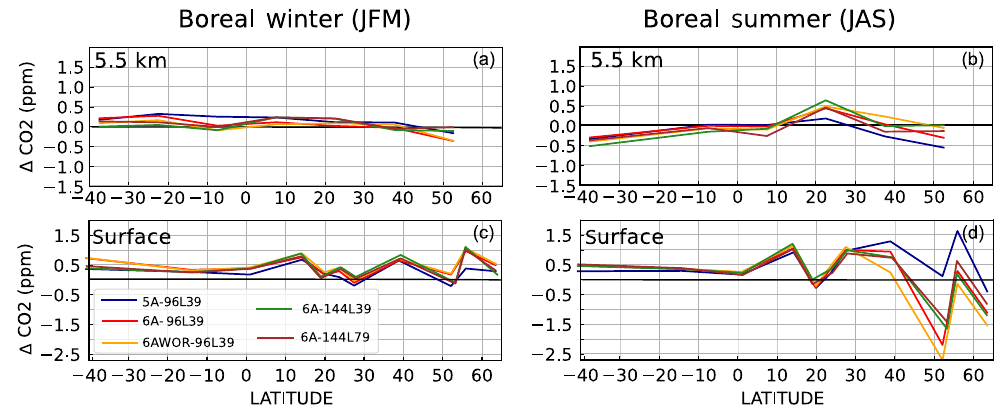
Figure 7. Latitudinal mean distribution of the CO 2 bias (modelled – observed) between 5 and 6km above sea level in the free tropo- sphere (a, b) and at the marine boundary layer (MBL) sites (c, d) for January–February–March (JFM) (a, c) and July–August–September (JAS) (b, d) during the period 2007–2010. The MBL sites are ZEP, ICE, SHM, AZR, MID, MNM, KUM, GMI, SMO, CGO. The 5–6km measurements come from the CONTRAIL